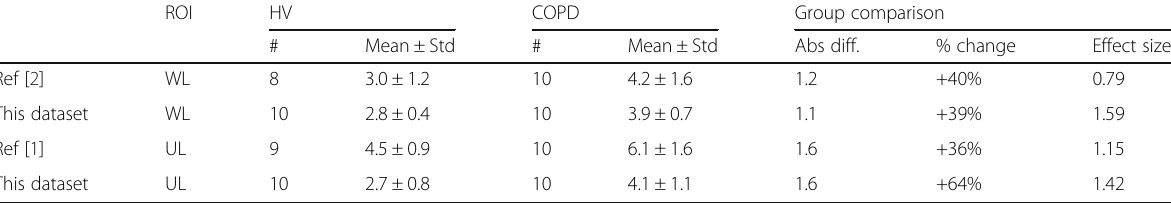
Table 3 Comparison of nK i Pat between our results and previously published ROI HV COPD Group